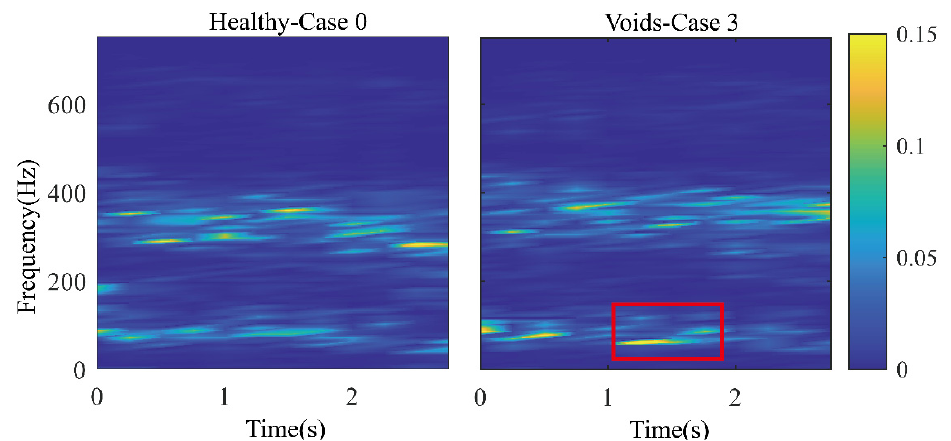
Figure 8. Wavelet packet energy spectrum.